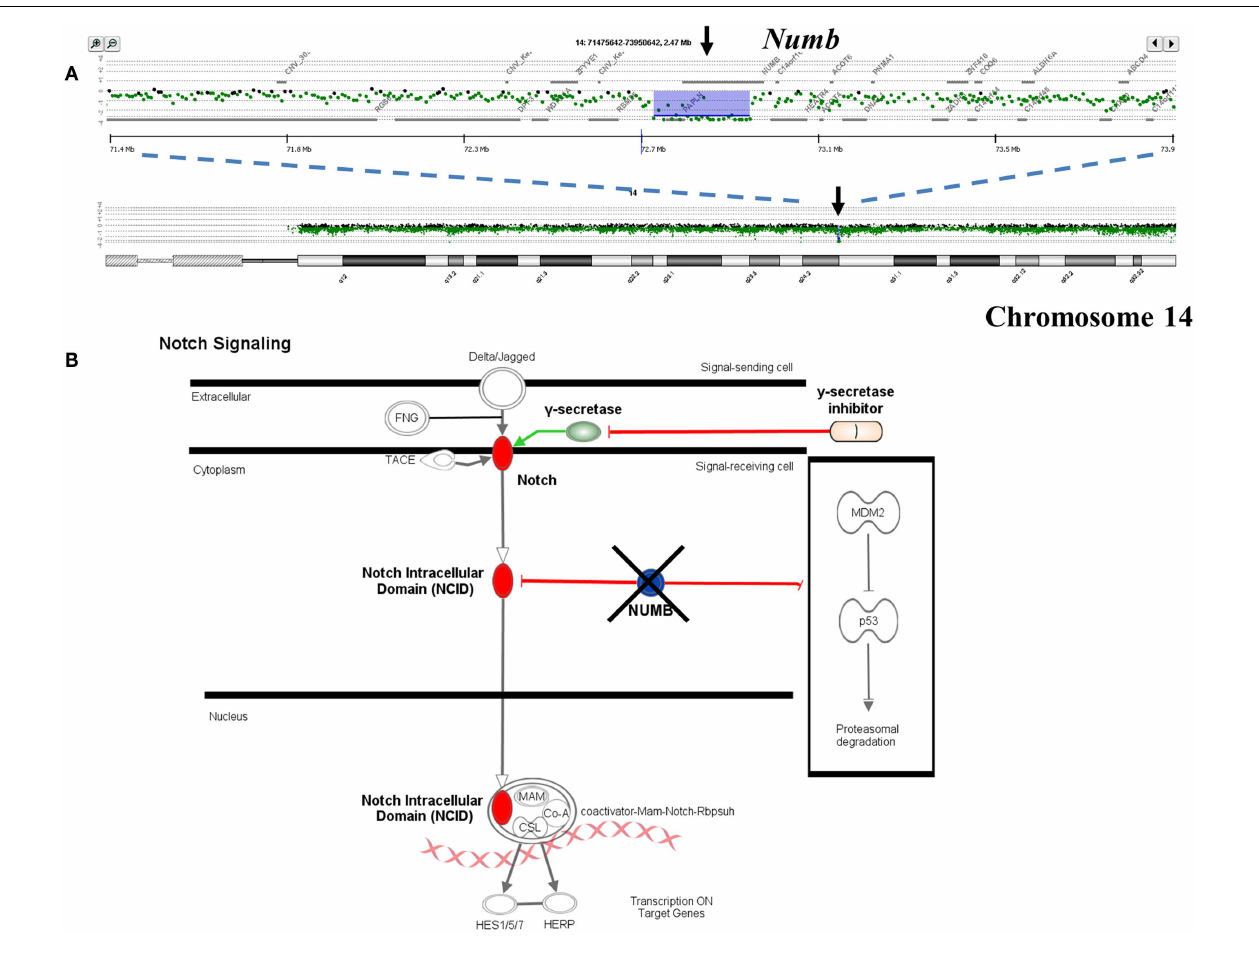
from a PDA sample. Shaded areas represent copy number aberrant regions called by ADM2 algorithm. (B) Concept map of Numb and its interactions with Notch and TP53